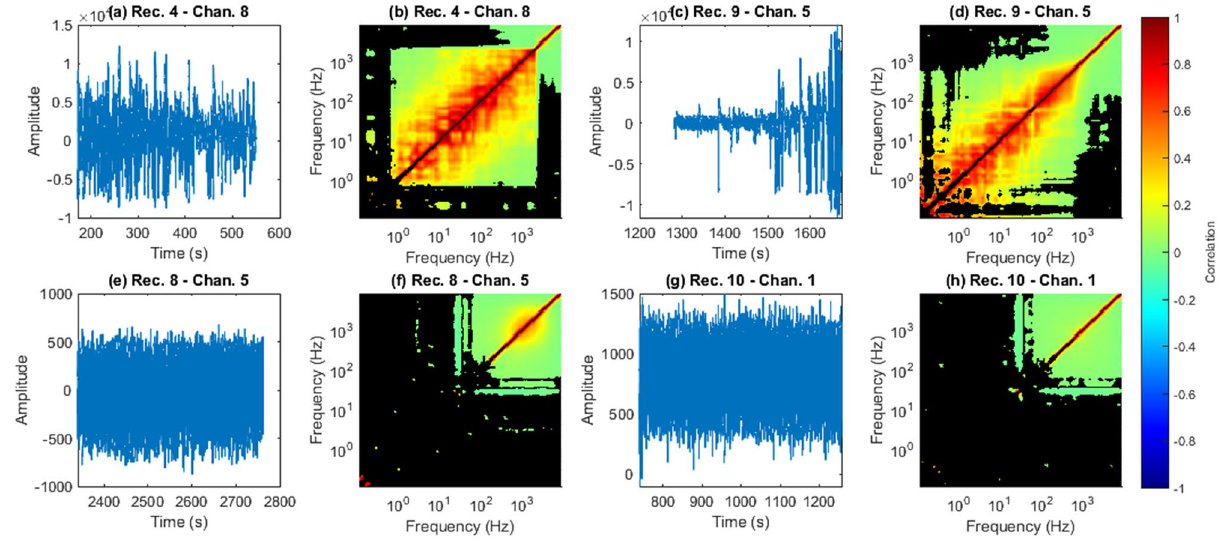
Figure 8. Time series and their associated inter-frequency maps from various session-channel pairs. In the inter-frequency maps, black indicates non-statistically significant relationships at an FDR α of 0.01. ( a ) and ( c ) contain strong time-series artifacts. Corresponding strong low-mid frequency power correlations are observable in ( b ) and ( d ). ( e ) and ( g ) contain no strong time-domain artifacts. ( f ) and ( h ) also contain no strong low-mid frequency power